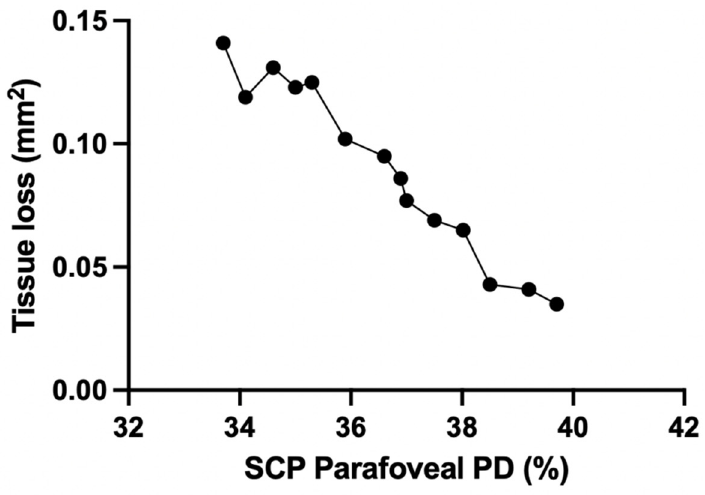
Figure 4. Linear correlation between SCP parafoveal PD (%) and tissue loss during the follow-up period (mm 2 ) in TL group. PD = perfusion density; SCP = superficial capillary plexus; TL = tissue loss .